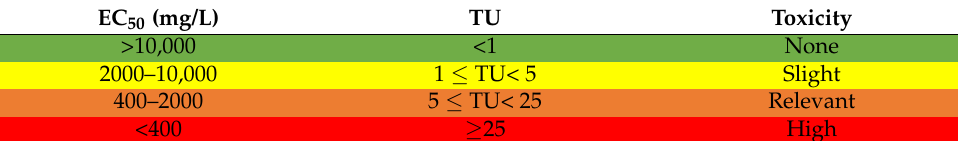
Table 2. Toxicity classification based on the sea-urchin embryo test Toxic Units